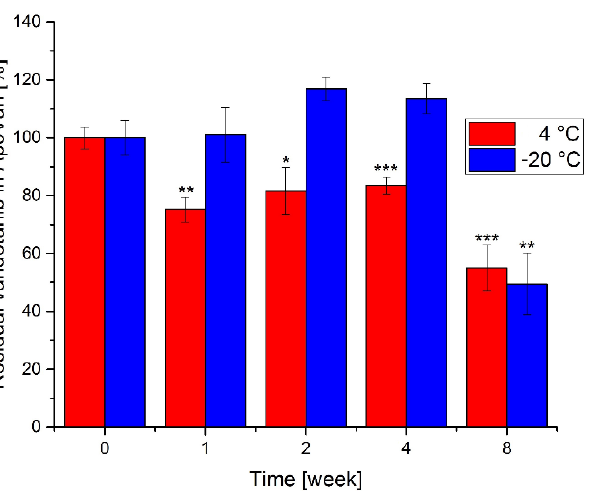
Figure 3. The stability of ApoVan at 4 °C and −20 °C. Values are mean ± SD from three independent experiments. * p < 0.05, ** p < 0.01, *** p < 0.001, significance was related to control values.